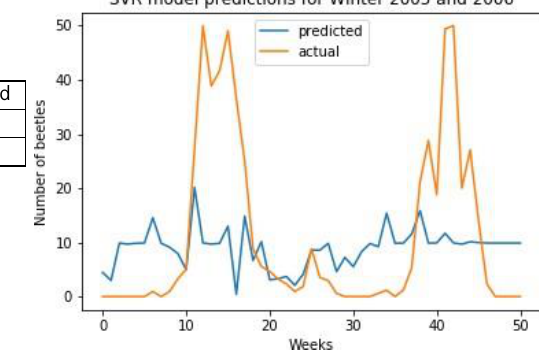
Figure 21. SVR Model predictions for Summer 2005 and